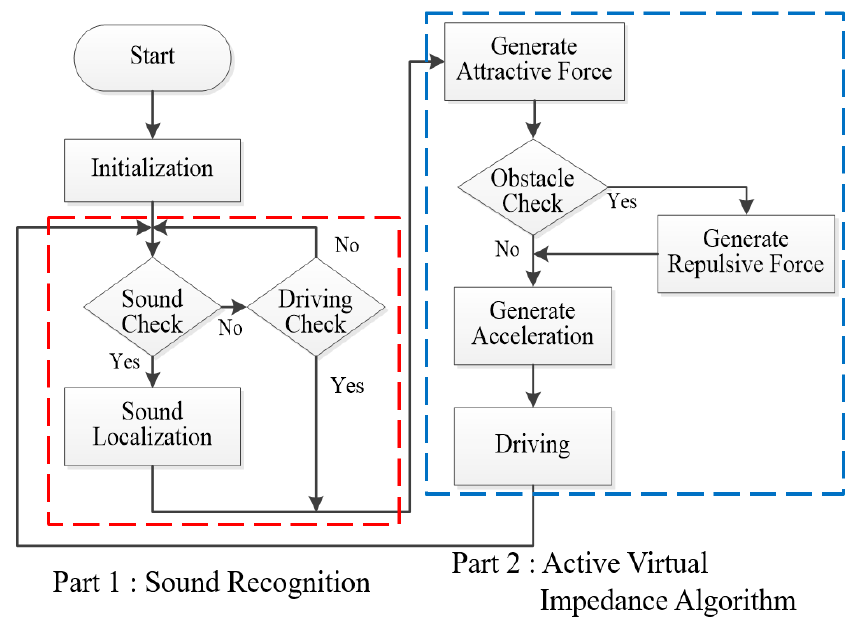
Figure 7. Flowchart of the sound source tracking mobile robot system.